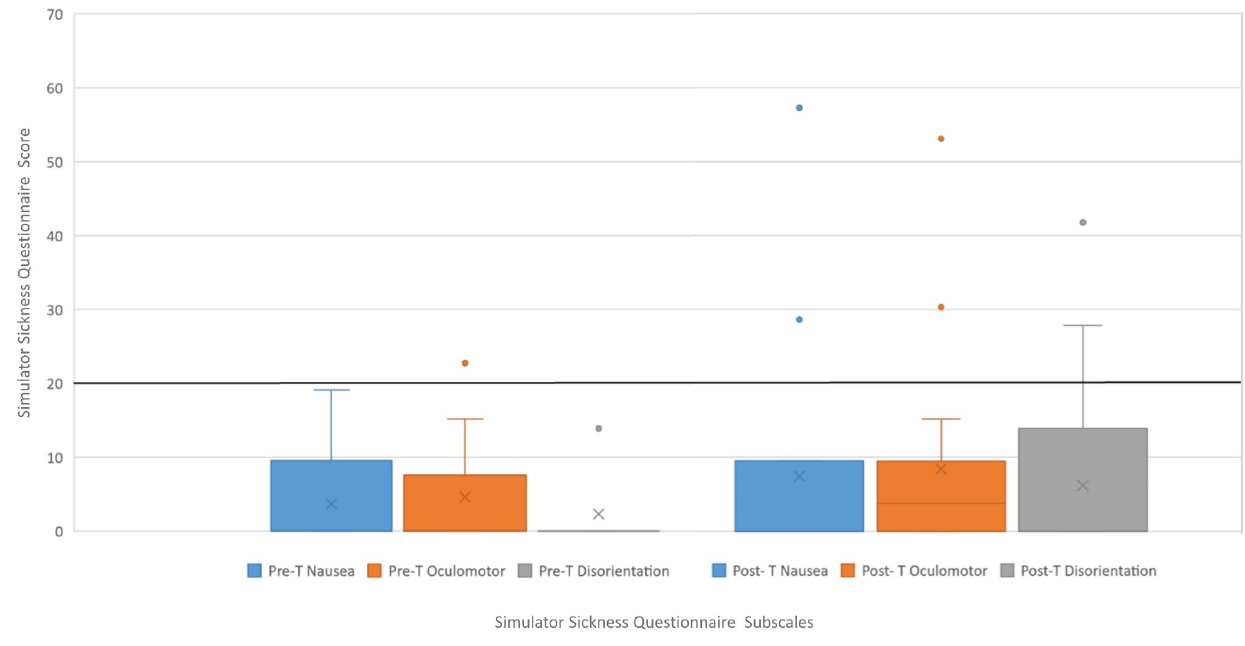
Fig 6. Boxplot distribution of Pre-Post SSQ assessment.